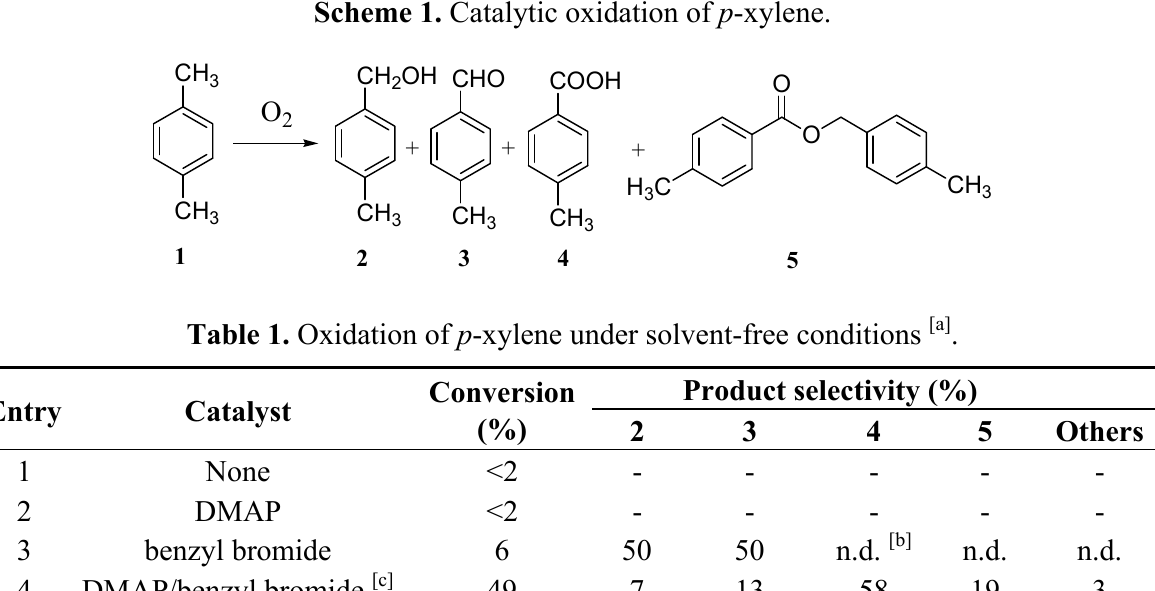
Scheme 1. Catalytic oxidation of p -xylene.